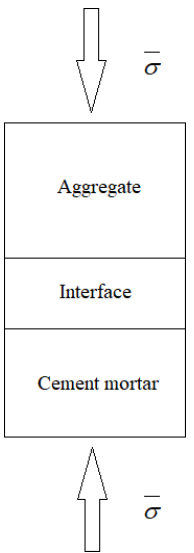
Figure 1: series model considering microscopic